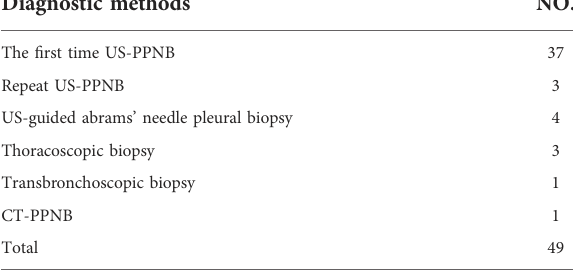
TABLE 1 Clinical diagnostic methods of 49 cases of